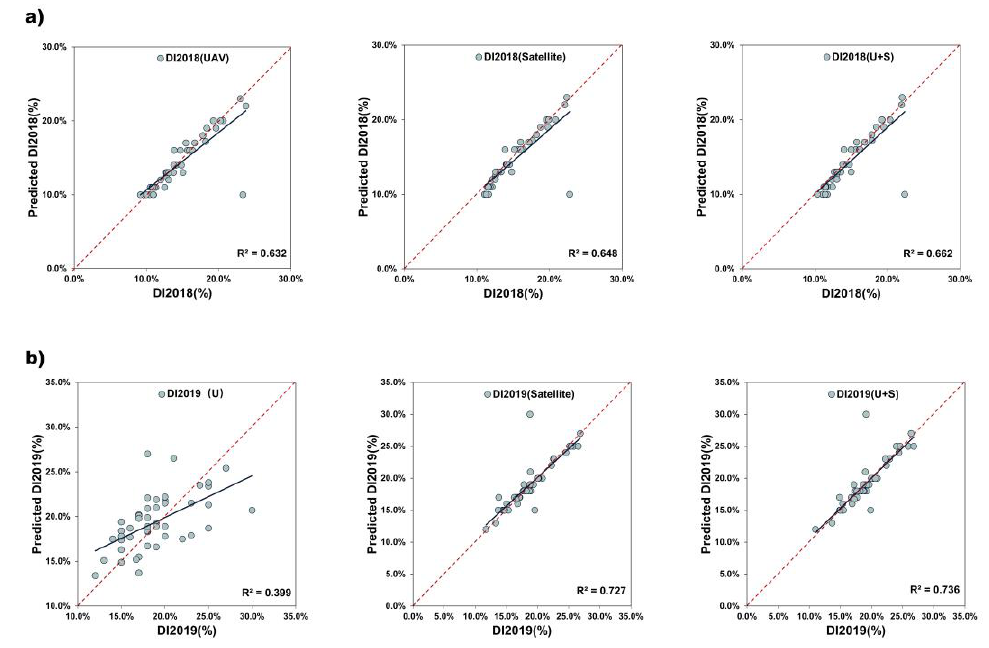
Figure 13. Cross-validation of measuring against SVR-based results. The red line is the bisector, and the black line is trendline. ( a ) shows Cross-validation of measuring against SVR-based results for DI2018. ( b ) shows Cross-validation of measuring against SVR-based results for DI2019.